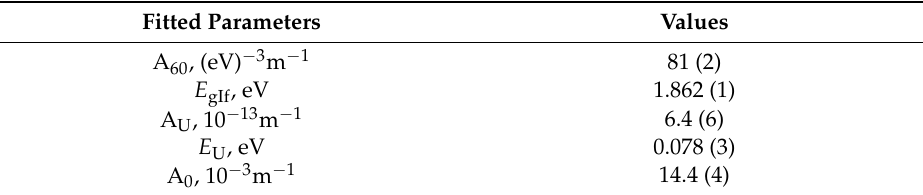
Figure 3. Diffuse reflectance spectrum ( ● ) and the calculated spectrum of Kubelka–Munk function ( ■ ) of SbSI gel. The red solid curve represents the fitted theoretical dependence (1) for the sum of indirect forbidden absorption without excitons and phonon statistics, Urbach ruled absorption, and constant absorption term ( T = 296 K; values of the fitted parameters are given in Table 1). Table 1. Values of parameters of Equation (1) determined from the fitting of the Kubelka–Munk function of SbSI gel presented in Figure 3.